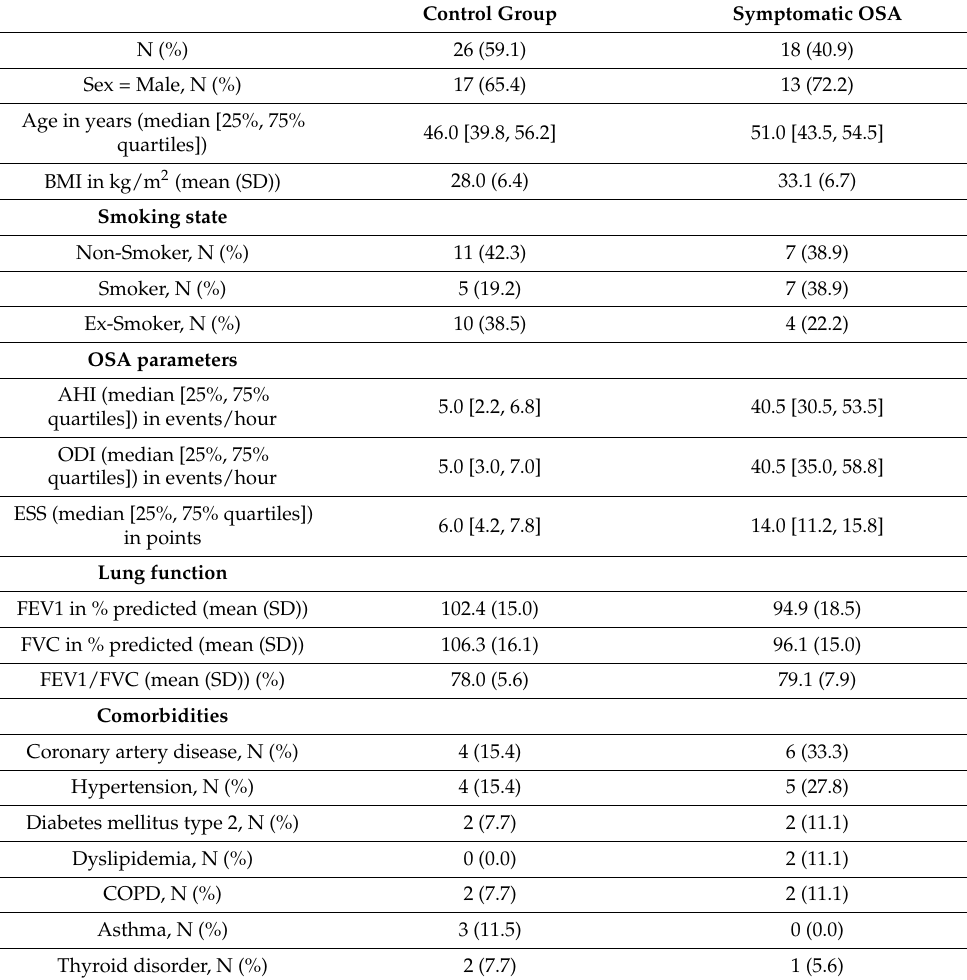
Table 1. Patient characteristics of the symptomatic OSA group and Control group. Control Group Symptomatic